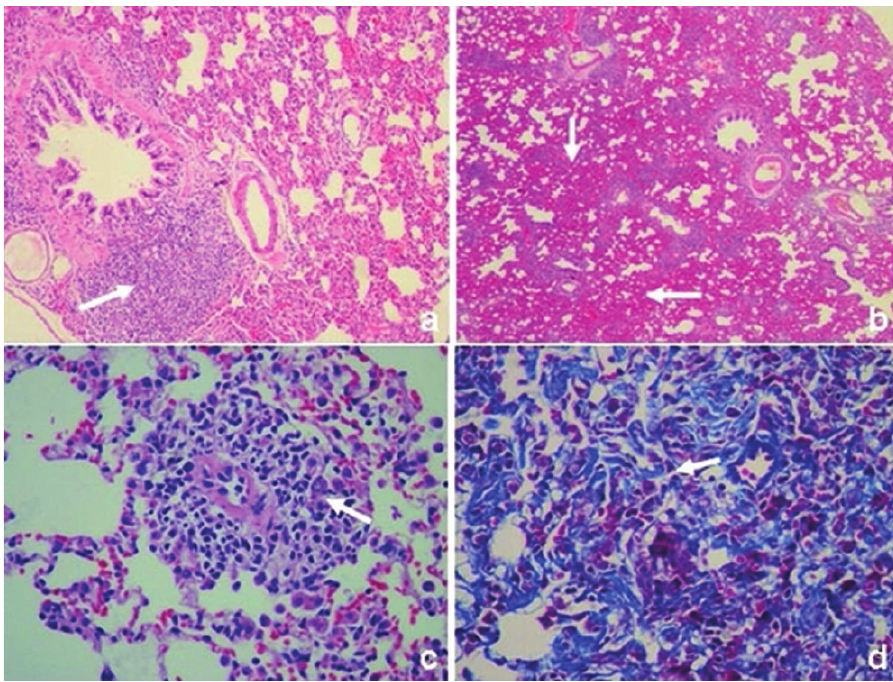
Figure 4 - Histopathological findings in the biomass smoke-exposed group (Group III). (a) peribronchial inflammation (arrow) (H&E, 6 10). (b) peribronchial, perivascular, and interstitial inflammation (arrows) (H&E, 6 40). (c) perivascular inflammation (arrow) (H&E, 6 40). (d) parenchymal infiltration and fibrosis (arrow). (Masson’s trichrome, 6